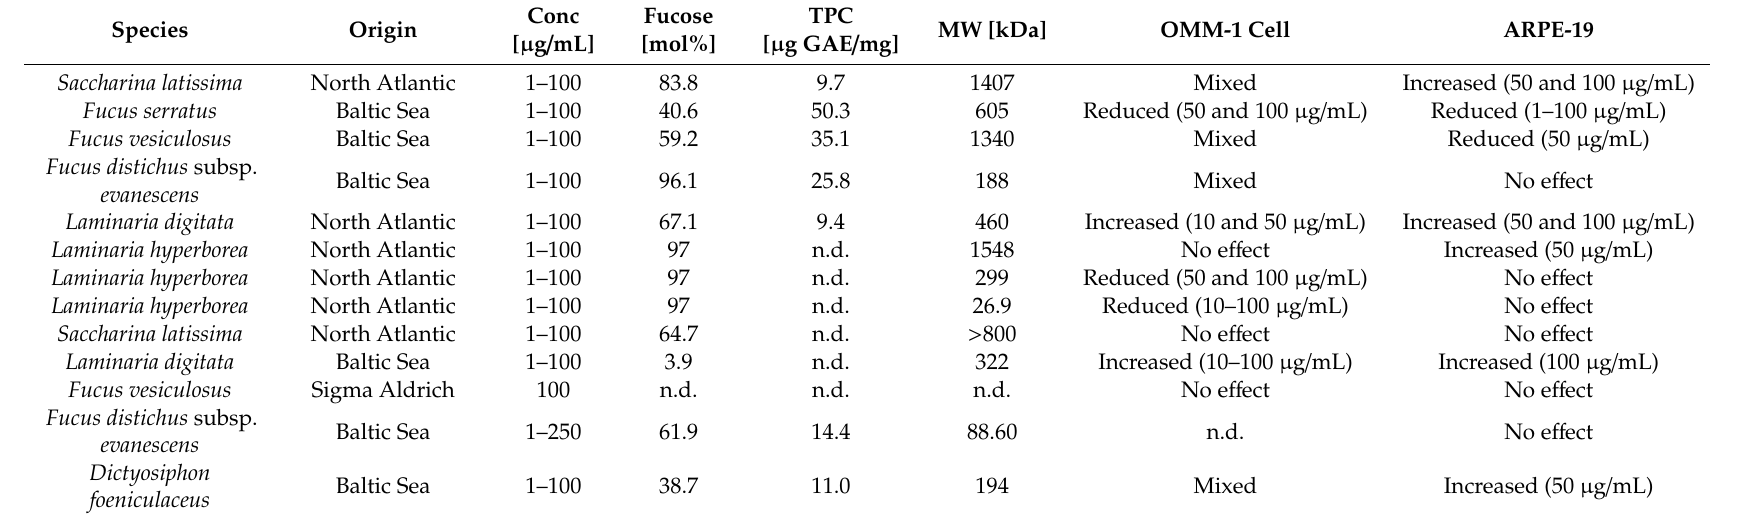
Table 3. List of tested fucoidans,